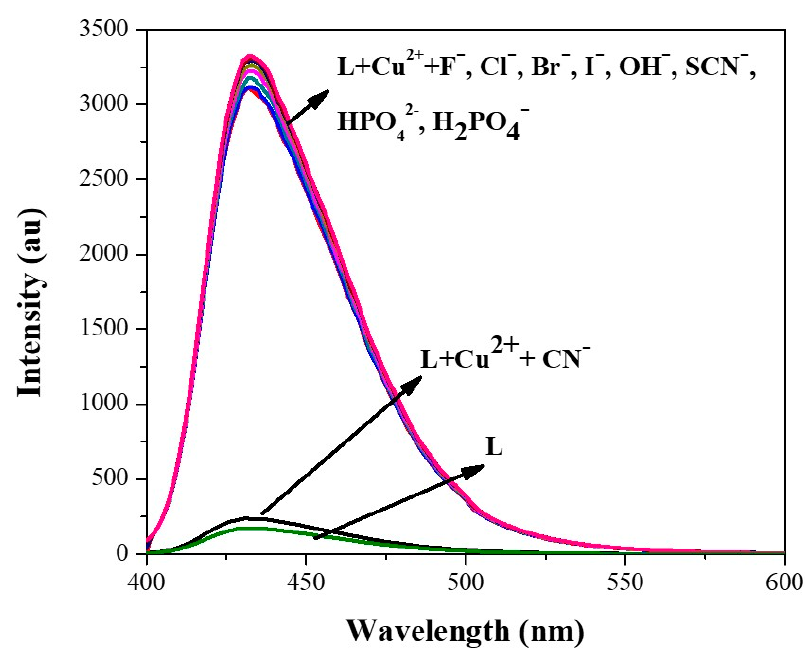
Figure 6. Fluorescence spectra changes of L–Cu 2+ complex (10 µM) to various anions (15 µM) in ethanol–water ( v / v = 7/3, 5 mM HEPES, pH 7.0) (at λ ex = 380 nm with excitation slit = 5 nm and emission slit = 5 nm).